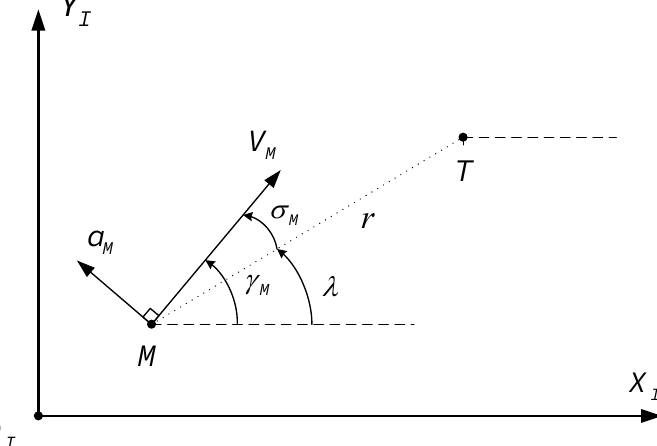
Figure 1. Engagement geometry for a stationary